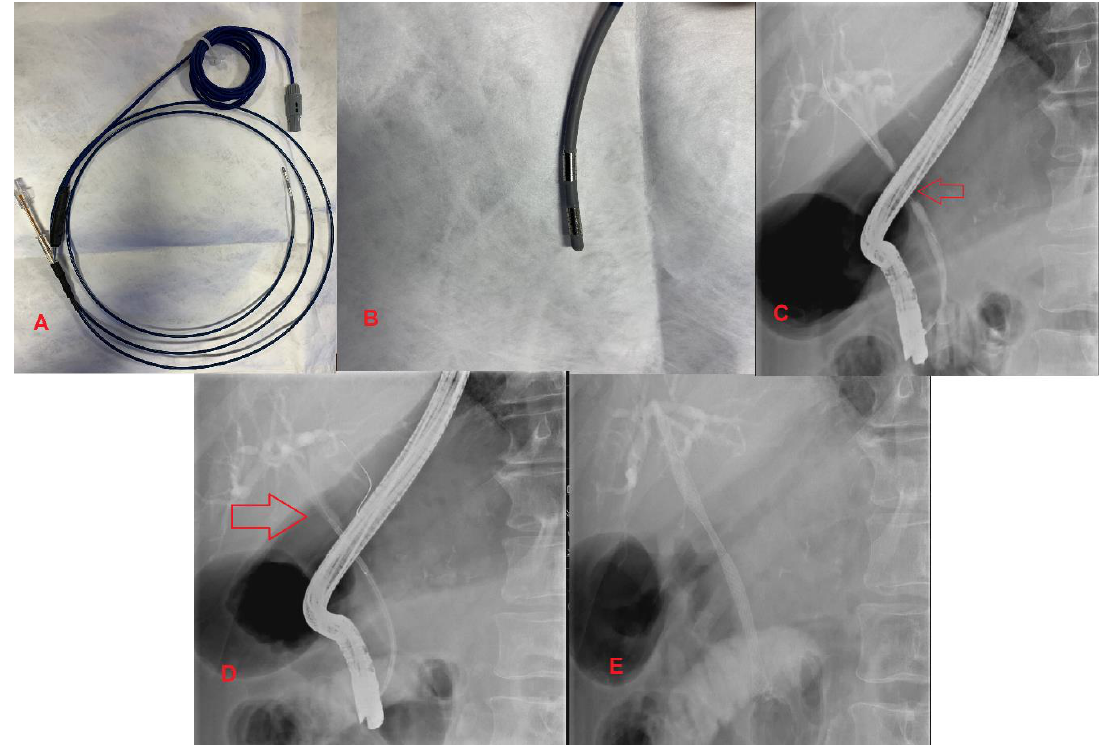
Figure 3. Extrahepatic Cholangiocarcinoma. ( A , B ) Habib Endo HPB Bipolar Radiofrequency Catheter; ( C ) Malignant common bile duct stricture; ( D ) The red arrow indicates a radiofrequency ablation catheter in place across a stricture; ( E ) UCSEMS placement status post RFA therapy.